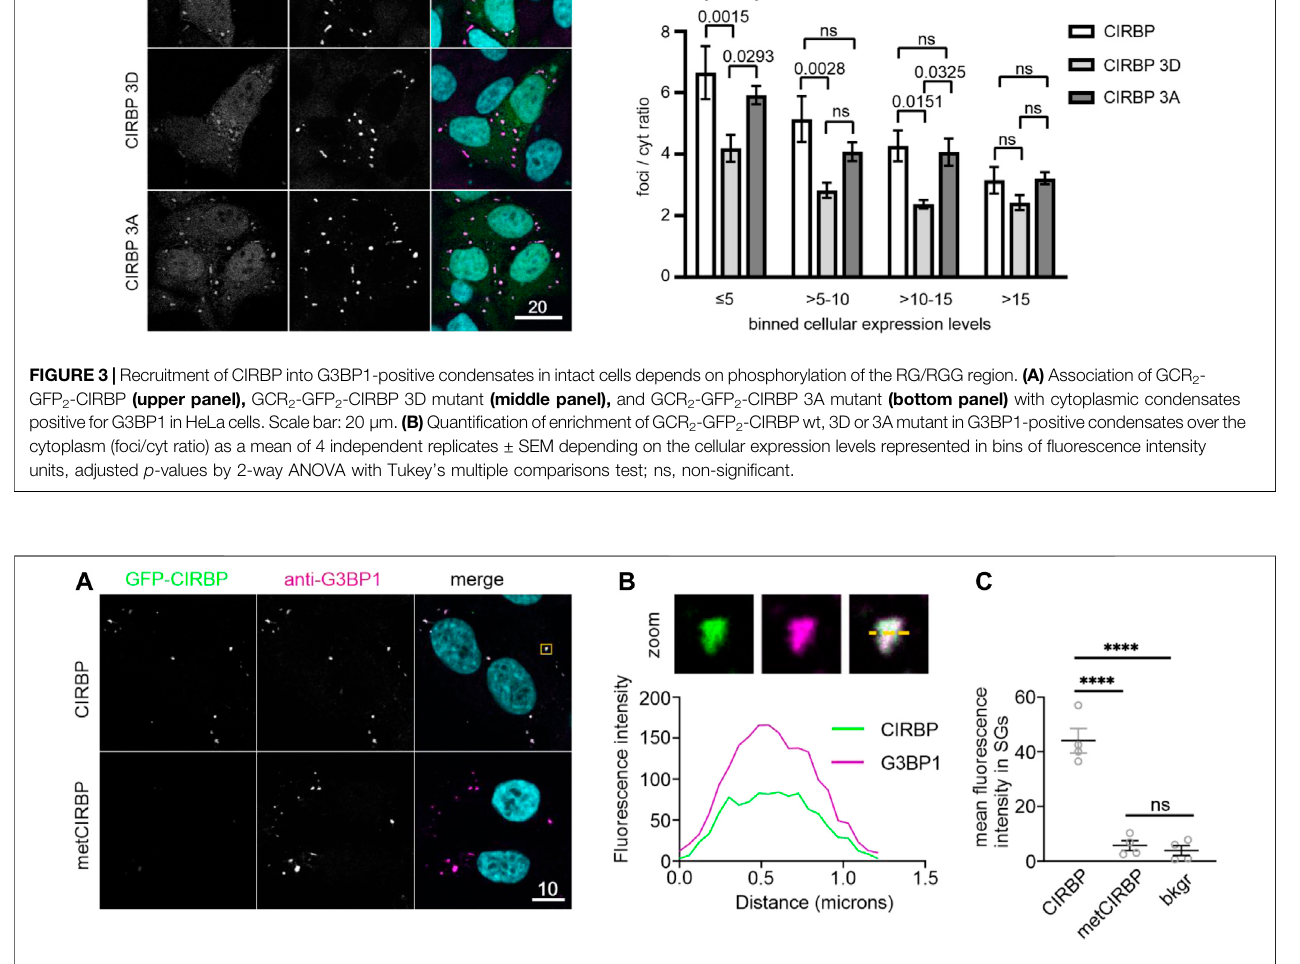
FIGURE 4 | PRMT1-mediated arginine methylation of CIRBP-RGG reduces its SGs recruitment. (A) Association of CIRBP-EGFP (upper panel) and methylated CIRBP-EGFP (metCIRBP; lower panel) with SGs in semi-permeabilized HeLa cells. Scale bar: 10 μ m. Yellow box indicates the zoomed-in images shown in Figure4B . (B) Unmodi fi edCIRBP completely enterstheSGasshown byazoomed-inimageofanexemplarySGand plotpro fi les of fl uorescenceintensitiesforG3BP1 andGFP-CIRBPalongtheyellowline. (C) Quanti fi cationofthemean fl uorescenceintensityofCIRBP-EGFPandmethylatedCIRBP-EGFPinSGsfor4independent experiments using CIRBP from 2 independent methylation reactions with ≥ 44 SGs ± SEM, adjusted p -value: **** p < 0.0001 by one-way ANOVA with Tukey ’ s multiple comparisons test; ns, non-signi fi